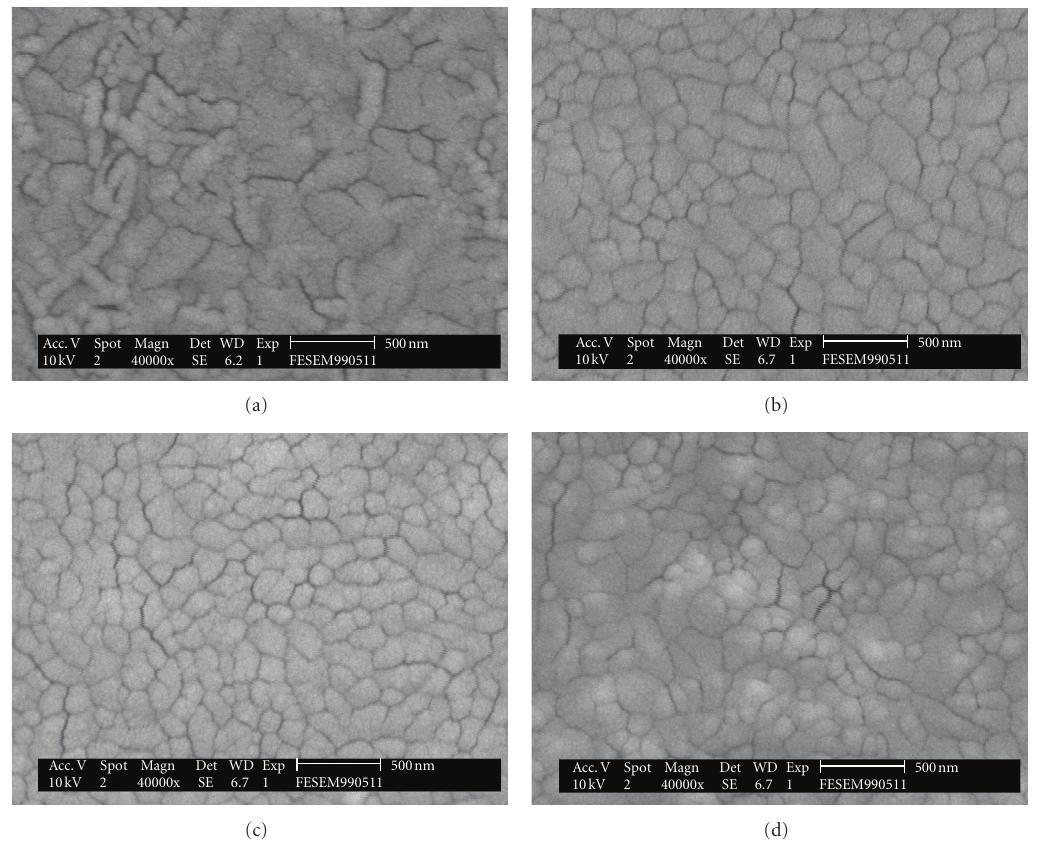
Figure 7: SEM photograph of pentacene films on NC-films with various doped content: (a) neat PVP 9wt% (cross-linked), (b) PVP+TiO 2 1wt%, (c) PVP+TiO 2 3 wt%, and (d) PVP+TiO 2 5